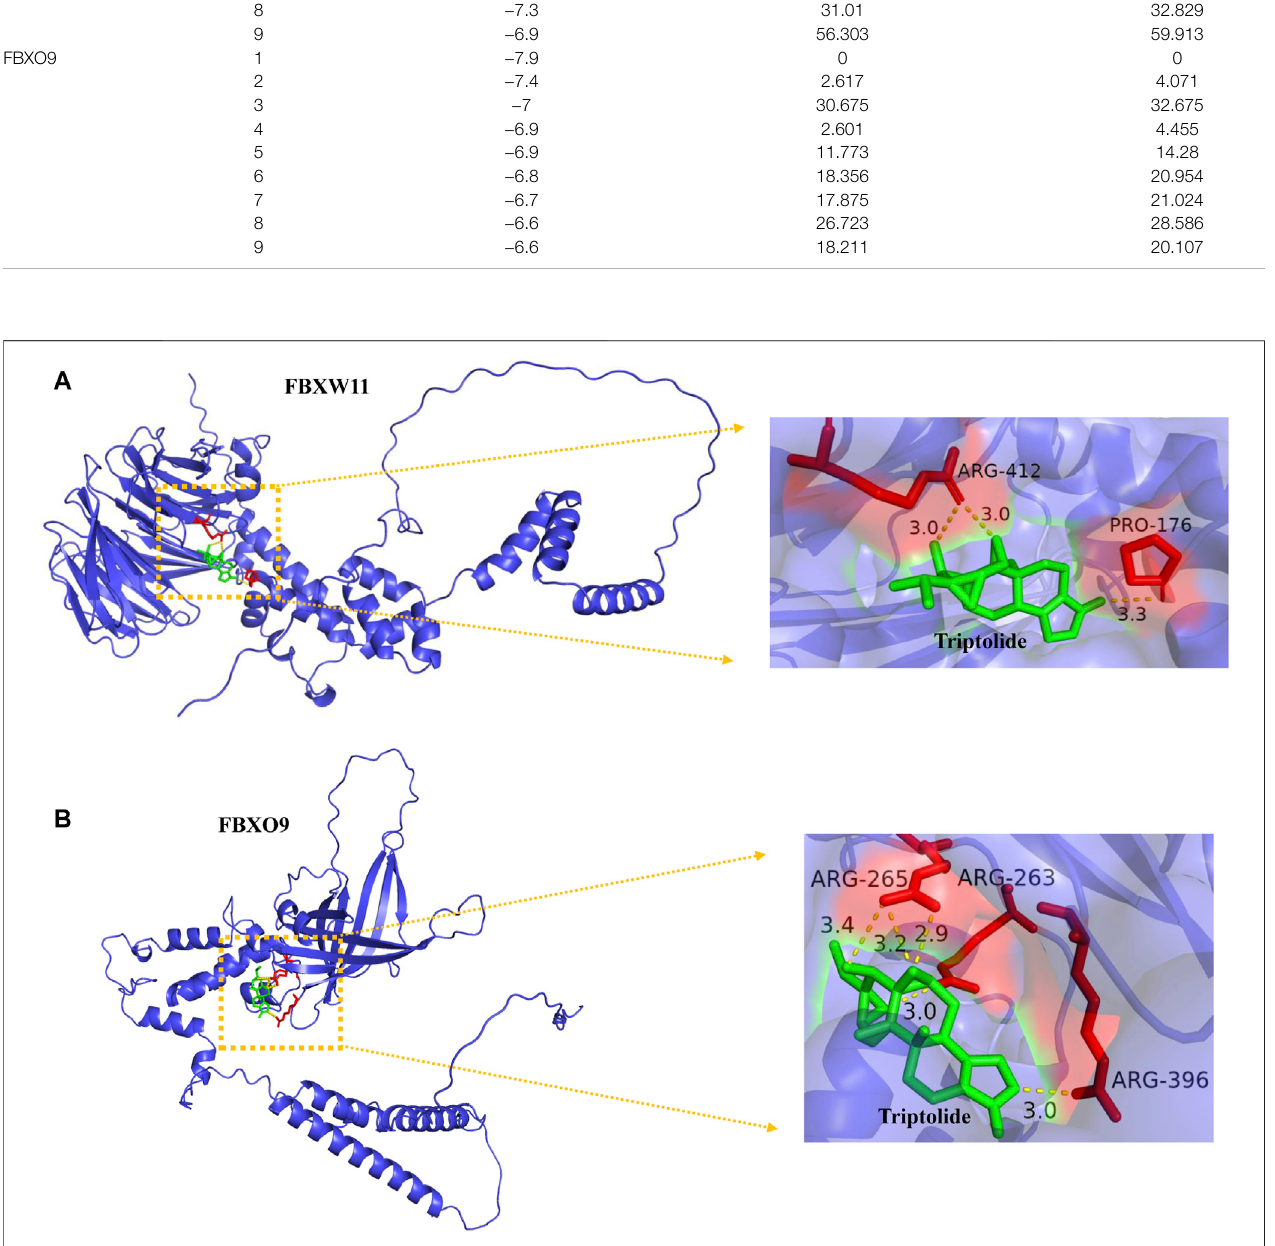
Frontiers in Genetics |